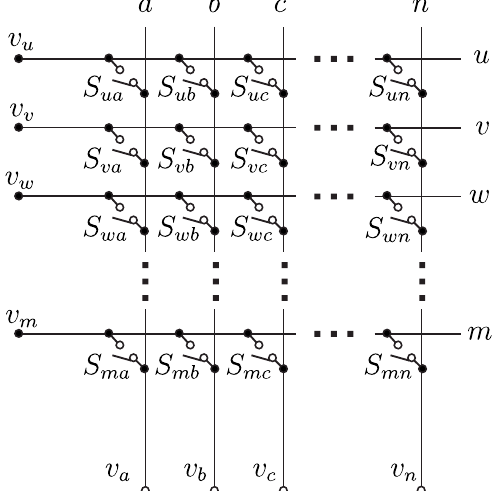
Figure 17. An m × n direct matrix converter.